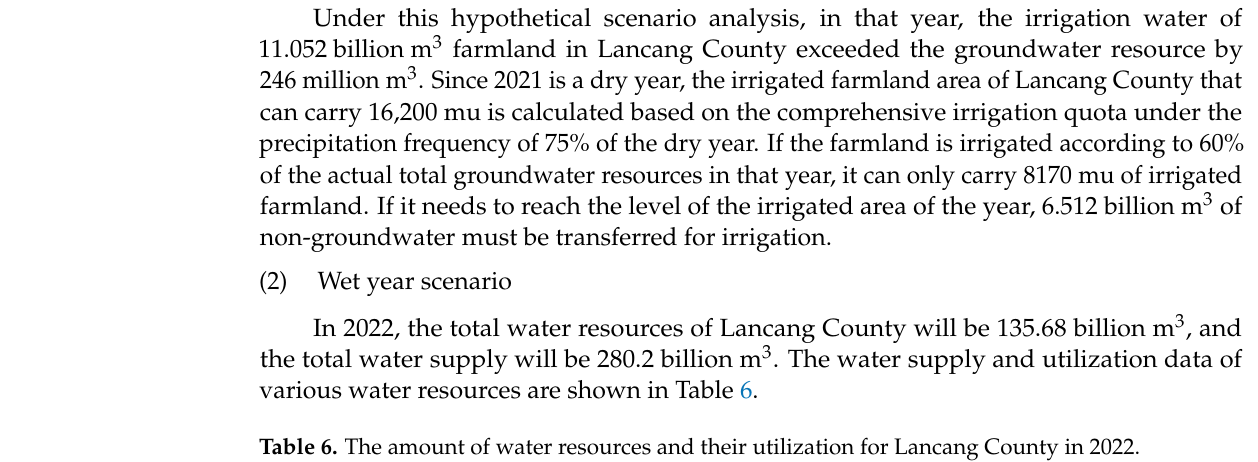
Table 6. The amount of water resources and their utilization for Lancang County in 2022.